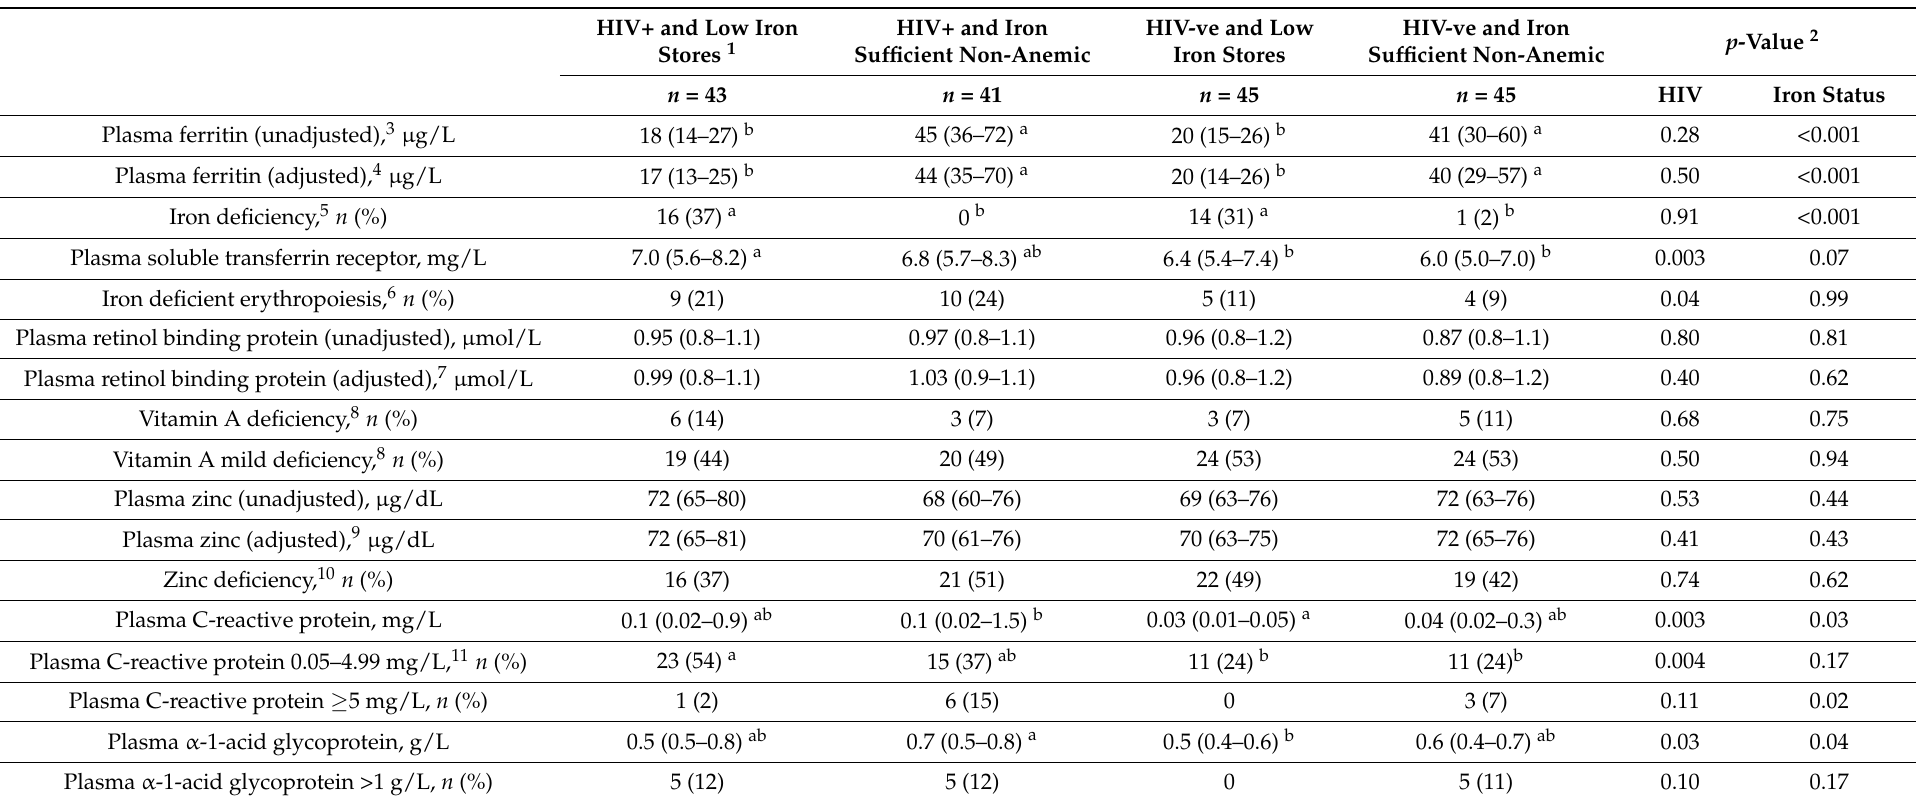
Table 3. Micronutrient status and inflammation in the four groups of South African children purposefully selected according to HIV and iron